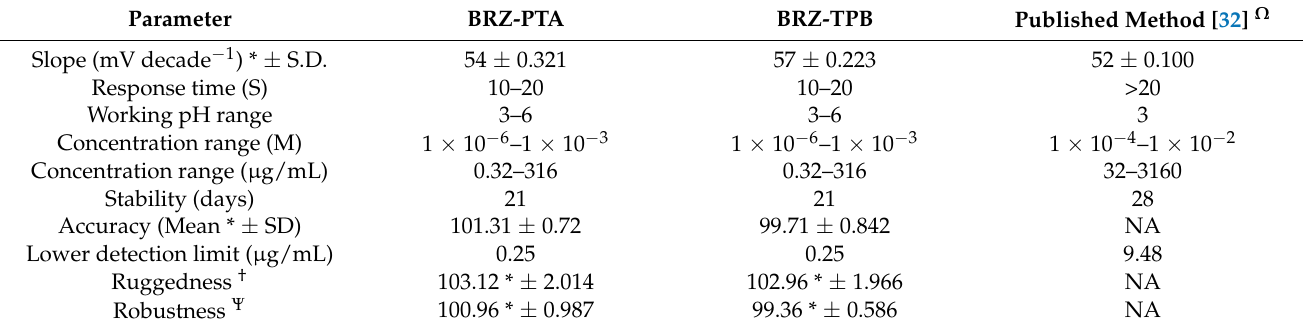
Table 1. Electrochemical response characteristics of the fabricated